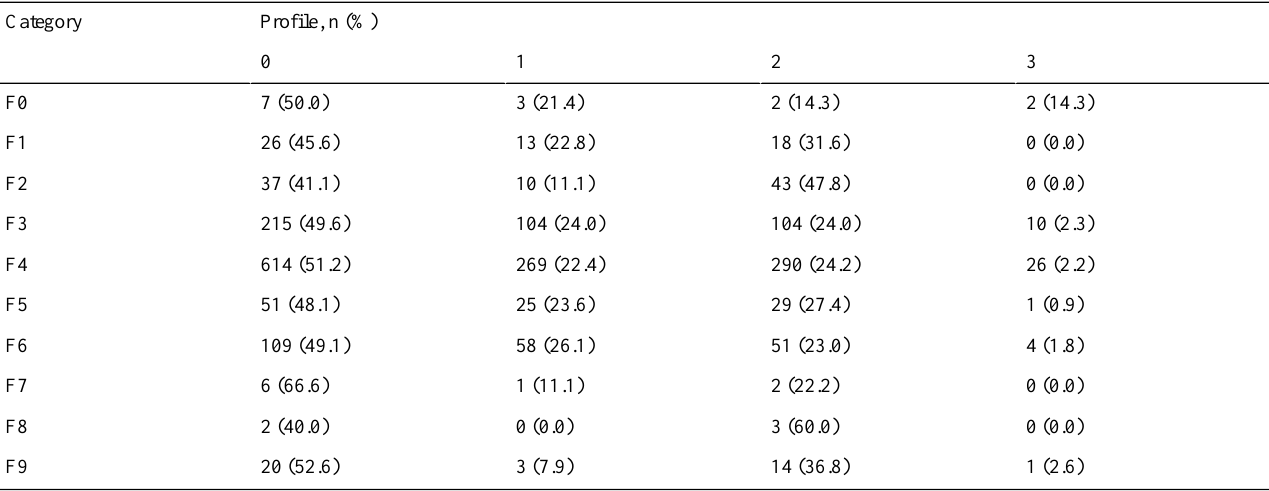
Table 3. Distribution of patient profiles according to the main ICD-10 diagnostic categories for psychiatric disorders (F0-F9). Profile, n